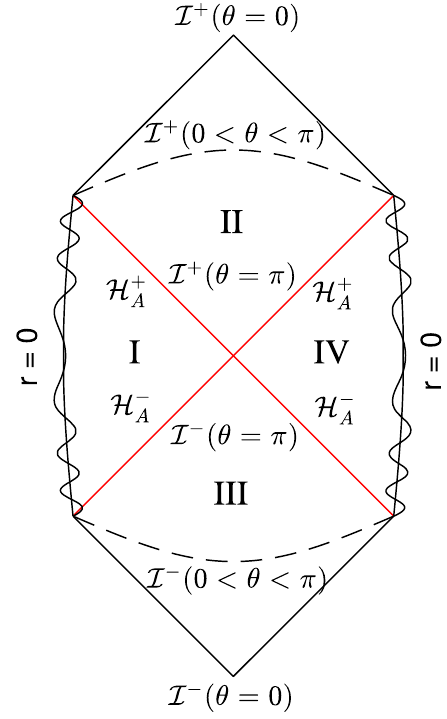
placed at the horizon for θ = π , and closes the diagram with a diamond shape for θ = 0. Since the metric is singular for θ = 0 ,π , the diagrams for those values do not represent the spacetime, so the conformal infin- ity in those cases has to be understood as a limit when θ → 0 ,π . The diagram is invariant under ϕ rotations